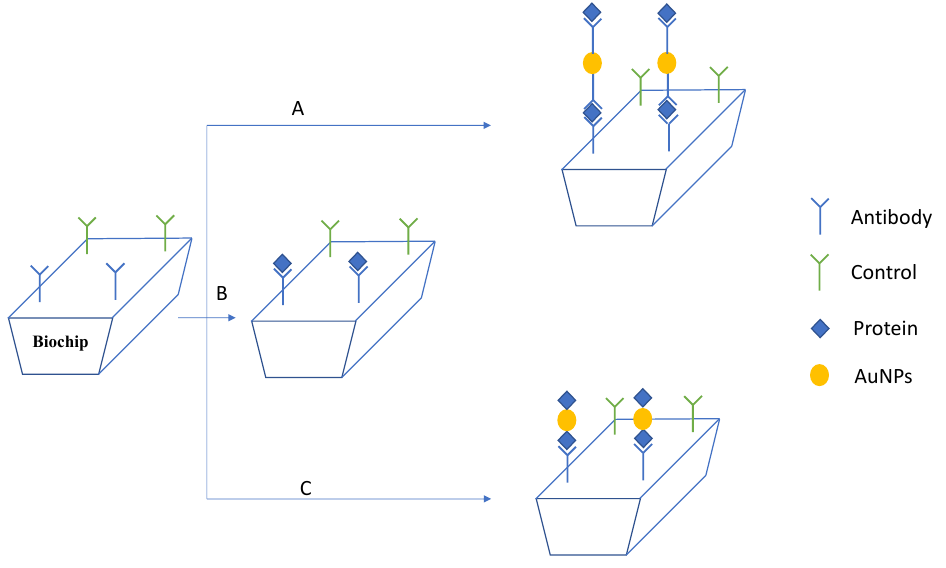
Figure 2. Representation of the SPR assays: Firstly, the biosensor was functionalized with antibody anti-ConA and anti-PNA. Following, ( A ) protein captured by AuNPs functionalized with antibody anti-ConA or anti-PNA, ( B ) protein in solution or ( C ) protein covalently linked to AuNPs was injected on the